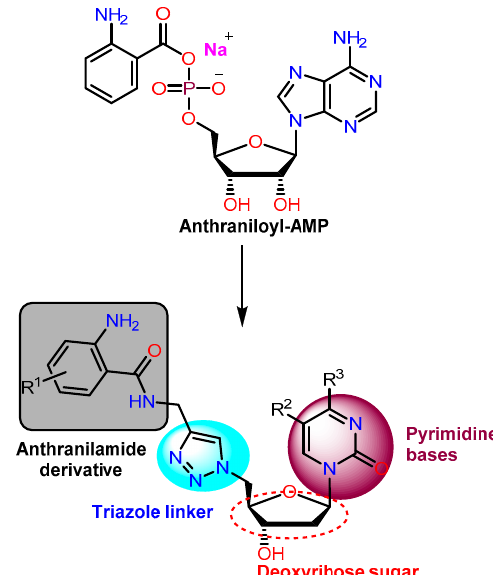
Figure 4. Ligand-based design of novel PqsA inhibitors.